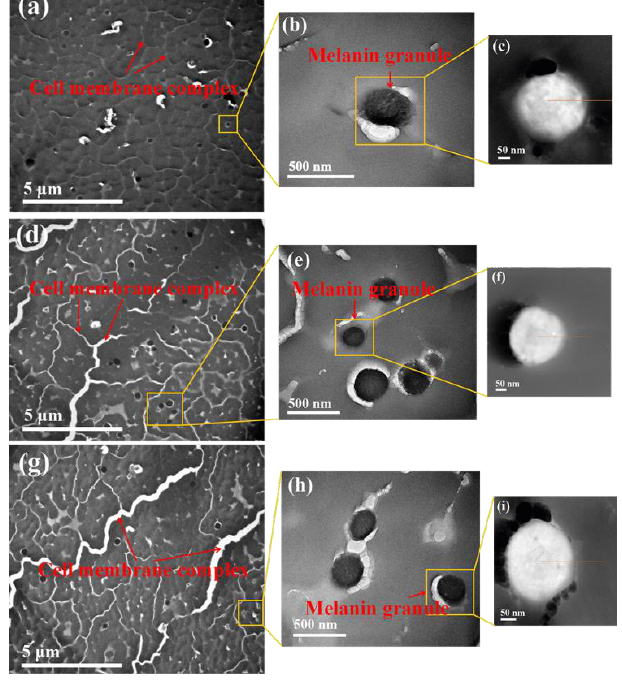
Figure 9. TEM images of camel hair under different magnifications. ( a – c ): control sample; ( d – f ): sample mordanted in the ethanol–water system; ( g – i ): sample mordanted in the water system. It is common knowledge that the chelating activity of melanin for ferrous ions is relatively strong [50]. Hence, to further investigate the influence of ethanol on the adsorption of ferrous ions on melanin granules, elemental mappings of the melanin granules mordanted in the ethanol–water and water systems were obtained using the TEM-EDS technique as shown in Figure 10.